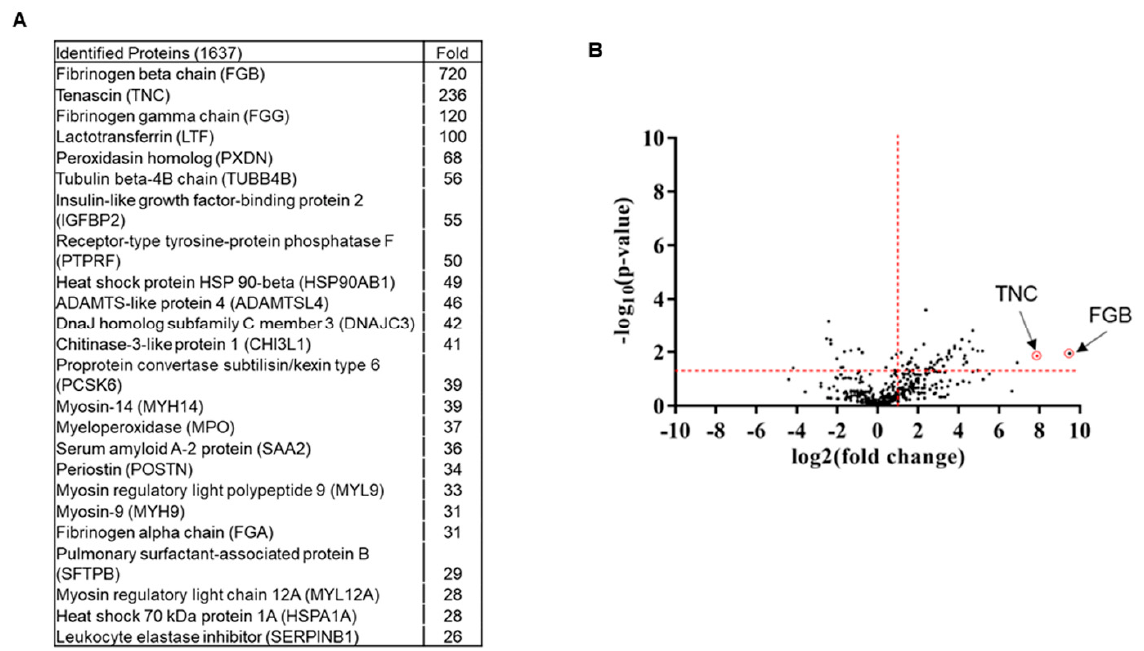
Figure 2. Comprehensive changes in plasma proteome profile of COVID-19 patients. ( A ) Top hits of COVID-19 exosomal proteins compared with normal exosomes are shown as a fold increase. ( B ) Volcano plot illustrates significant difference in the fold change of proteins in COVID-19 exosomes compared with normal exosomes. The x-axis represents log2 (fold change) and the y-axis is log 10 ( p -value) showing statistical significance. Horizontal dashed red-line showing p = 0.05 ( − log 10 (0.05) = 1.3) and vertical dashed red line represents fold change (COVID/normal exosomes) at 2 (log 2 (2) = 1). The absolute fold change and p -value 0.05 were considered as the threshold cut-off. TNC and FGB are shown in red circles.